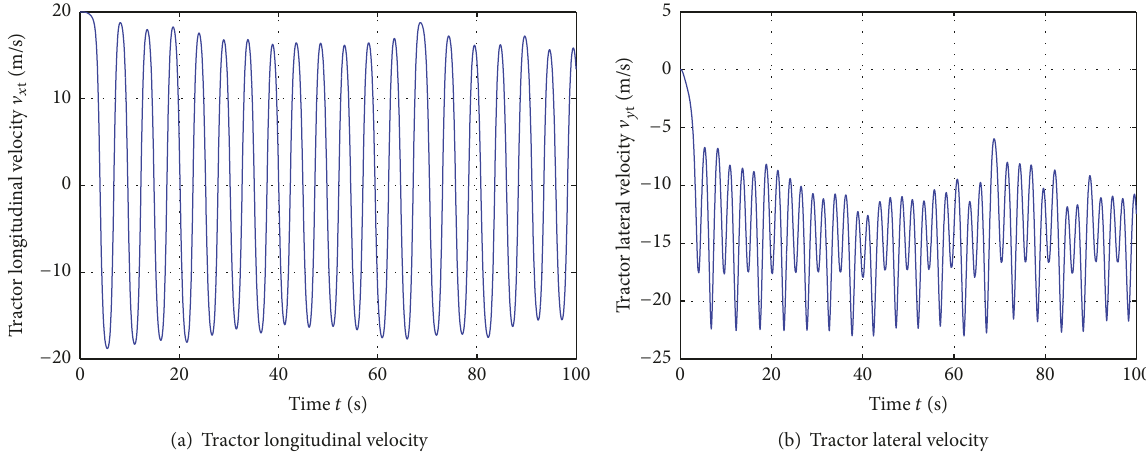
= 0.07 rad, 𝑓 = 0.2 s